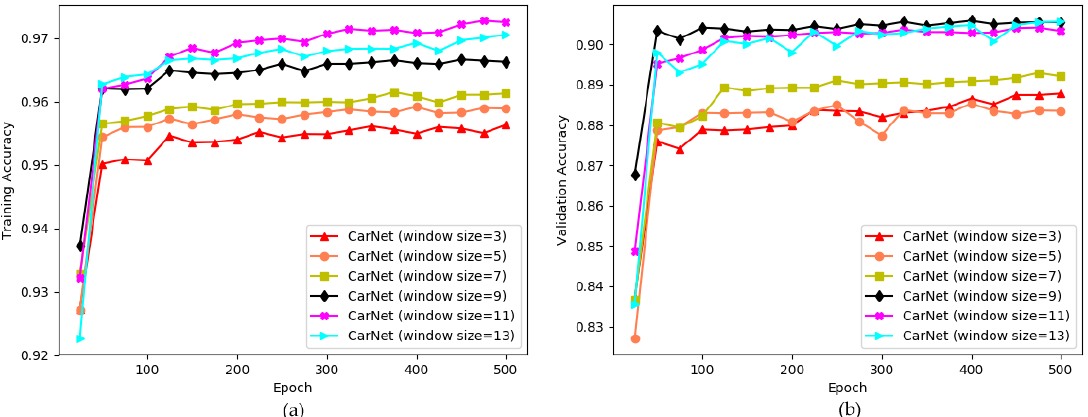
Figure 10. Experimenting different window sizes to build an optimal model. x-direction: number of epochs (500), y-direction: accuracy. ( a ) training accuracy; ( b ) validation